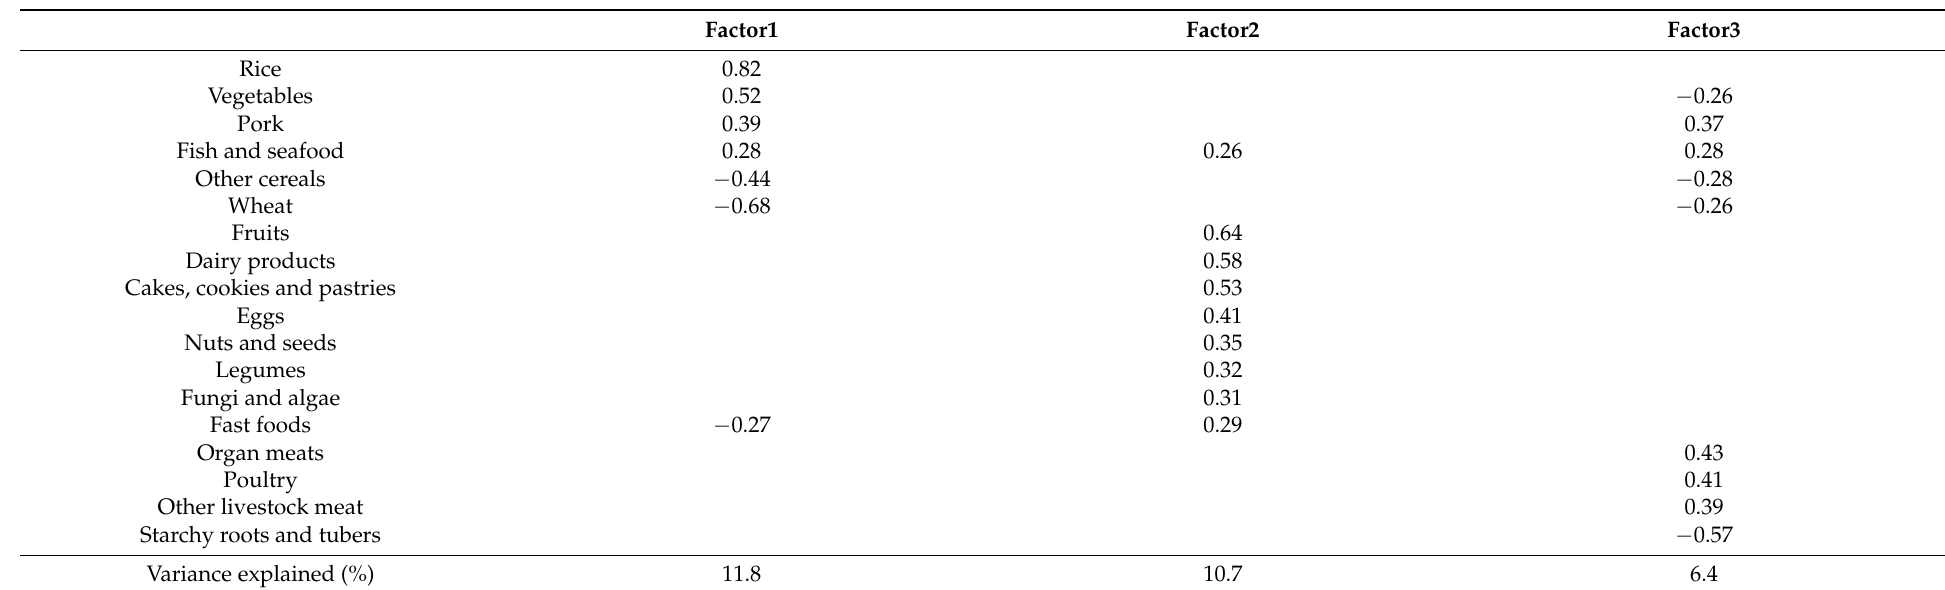
Table 2. Factor-loading matrix for dietary patterns identified by factor analysis among Chinese